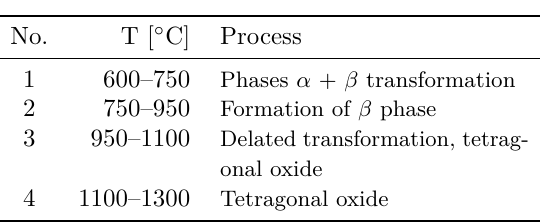
Table 3. Physical processes taking place in zirconium E110 alloy in different temperature intervals during LOCA accident conditions.